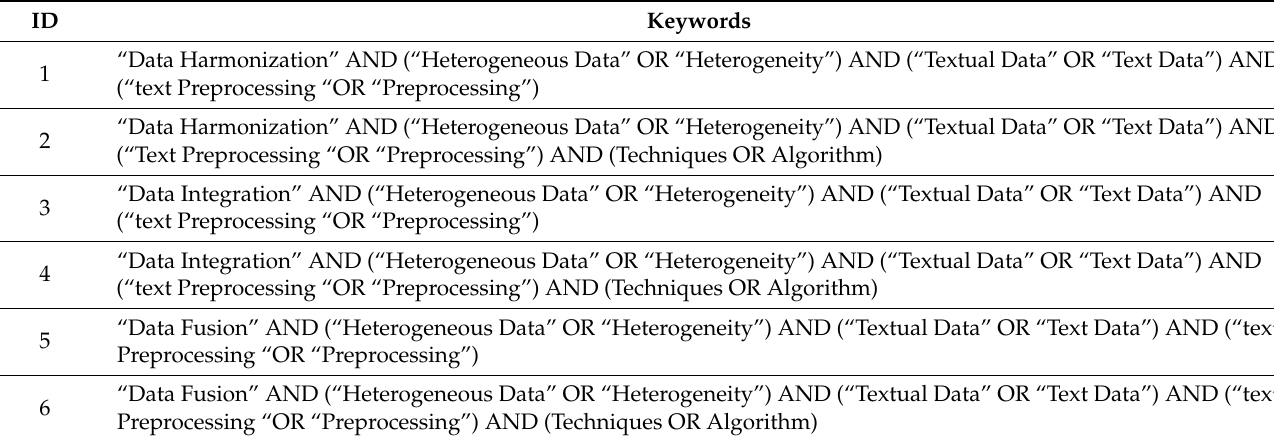
Table 1. Inclusion and exclusion criteria